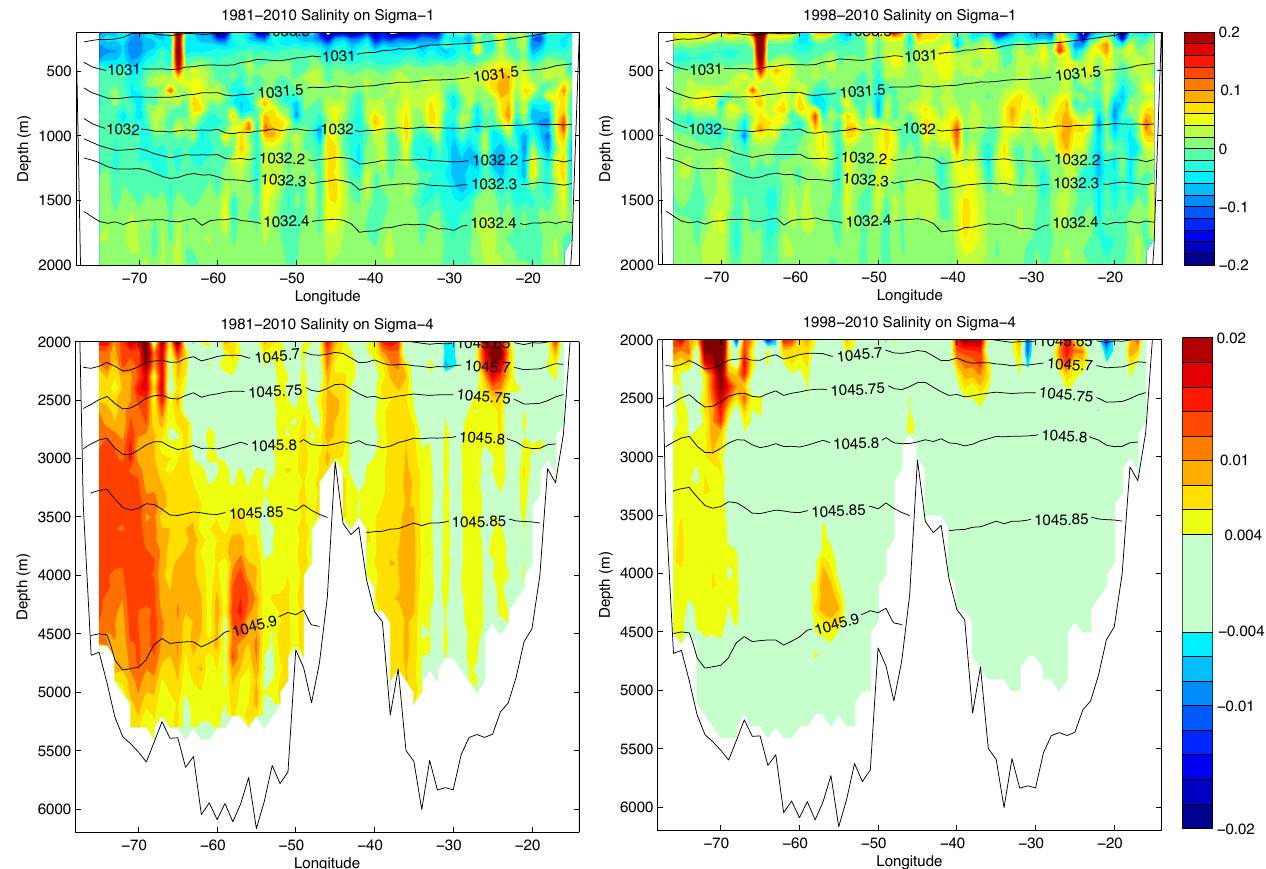
Fig. 12. Salinity changes on potential density surfaces across 25 ◦ N for the 1981 and 1998 hydrographic sections relative to the 2010 hydrographic section. Upper plots are for the upper ocean using σ 1 density surfaces (salinity contours are in 0.02 increments), lower plots are for the deep ocean using σ 4 density surfaces (salinity contours are in 0.002 increments, ± 0.004 denotes uncertainty). To facilitate comparison, each hydrographic section is bi-linearly interpolated onto a climatological potential density grids ( σ 1 and σ 4 ) computed from the Hydrobase 2 database (a seasonally averaged hydrographic climatology, see http://www.whoi.edu/science/PO/hydrobase). This approach assumes property linearity in space and also linearity of the equation of state which is reasonable over small changes in potential